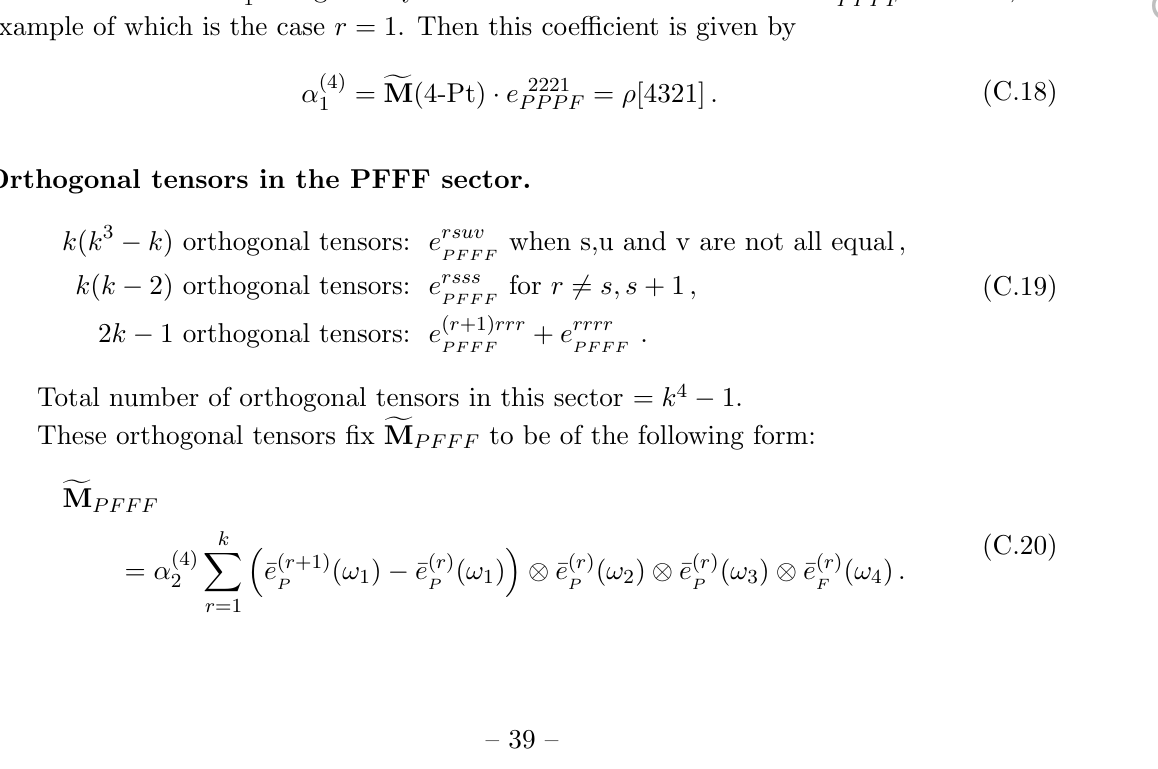
Table 5 . Arguments for the tensors trivially orthogonal to the array of 4 point contour correlators. The coefficient α (4)